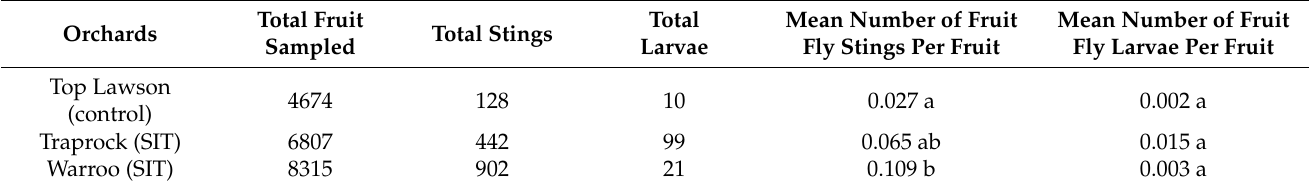
Table 1. Fruit fly stings and larvae recorded from stone fruit sampled at Pikes Creek packing shed from sterile and control orchards during the 2016/2017 stone fruit season.